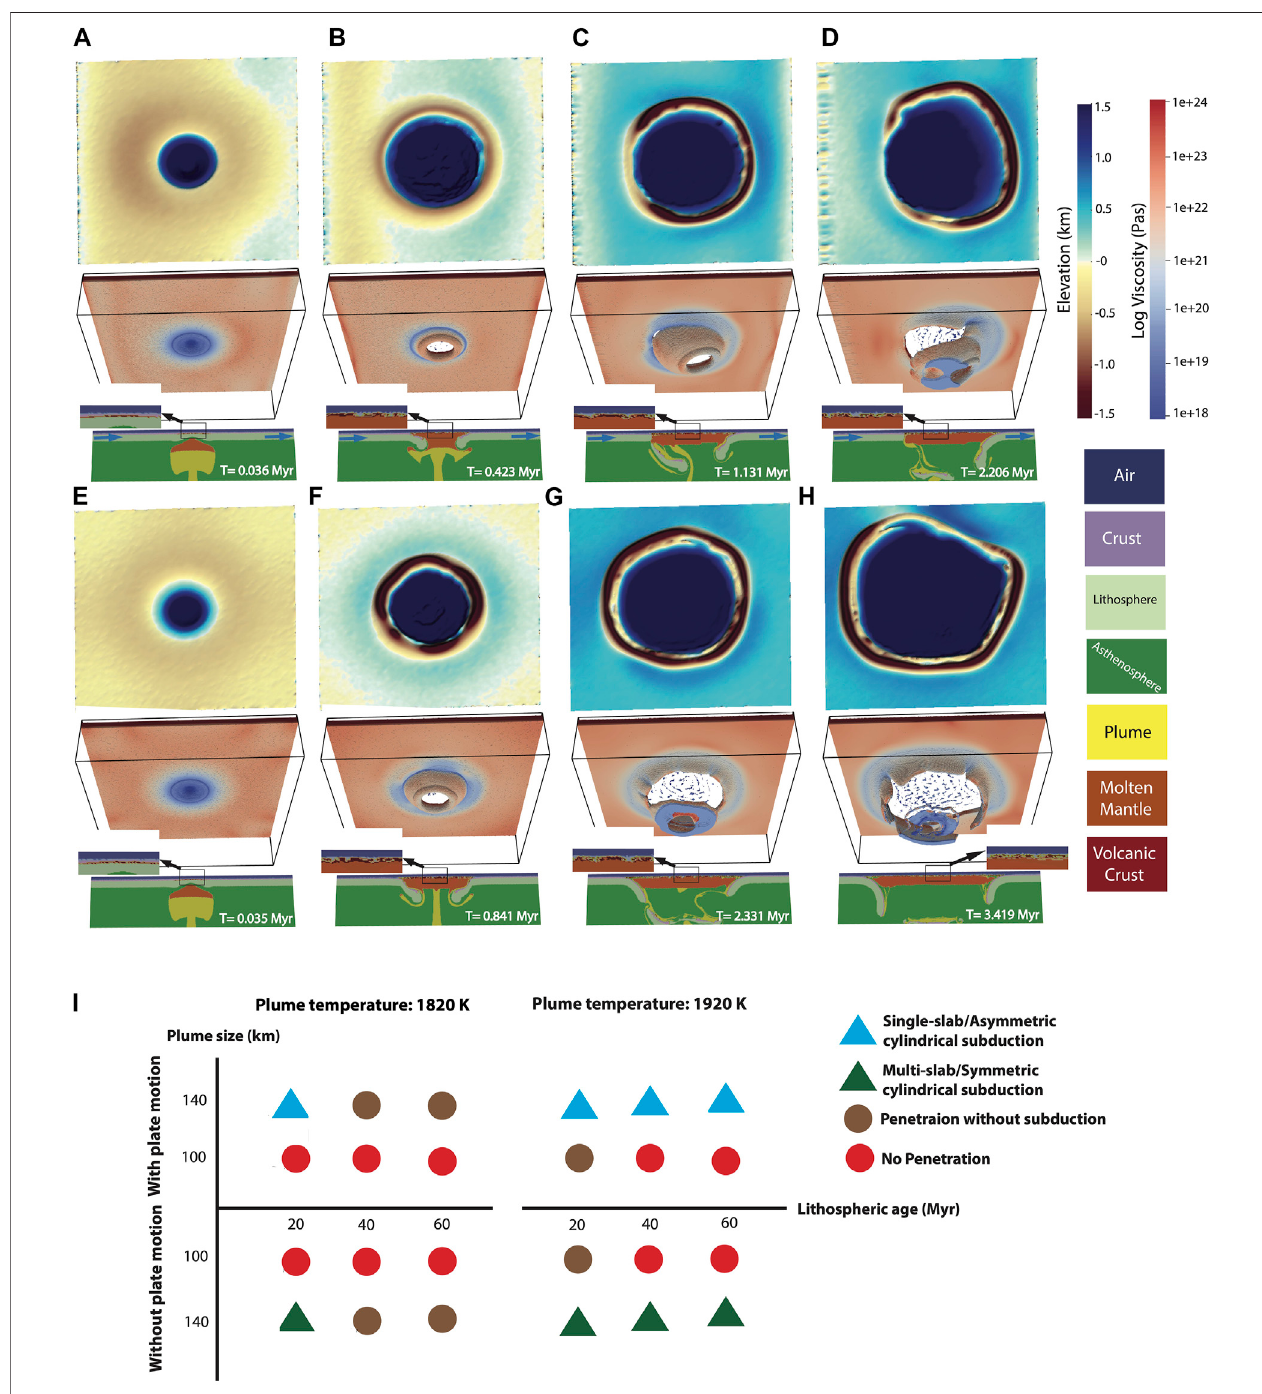
FIGURE 9 | Effect of plate motion on plume-lithosphere interaction (Baes et al., 2021). (A – D) Results of reference model of Baes et al. (2021) with 20 Myr oceanic lithosphere and a plume head with temperature excess of 200 K and head size of 140 km. This model shows that plate motion can cause asymmetric fl ow of the rising plume which causes slab break-off from one side of the circular trench. (E – H) Results of a model which is similar to that in (A – D) but without moving plate. The upper, middle and lower panels stand for surface topography (top view), viscosity fi eld of lithosphere and compositional fi eld (color codes as shown on the bottom-right side of fi gure) of a 2D cross-section through the model center, respectively. Insets zoom in on the uppermost lithosphere above the plume head. Blue arrows in lower panels of (A – D) indicate the direction of plate motion. (I) Summary of model results of Baes et al. (2021) showing that plate motion can cause either single-slab or asymmetrical cylindrical